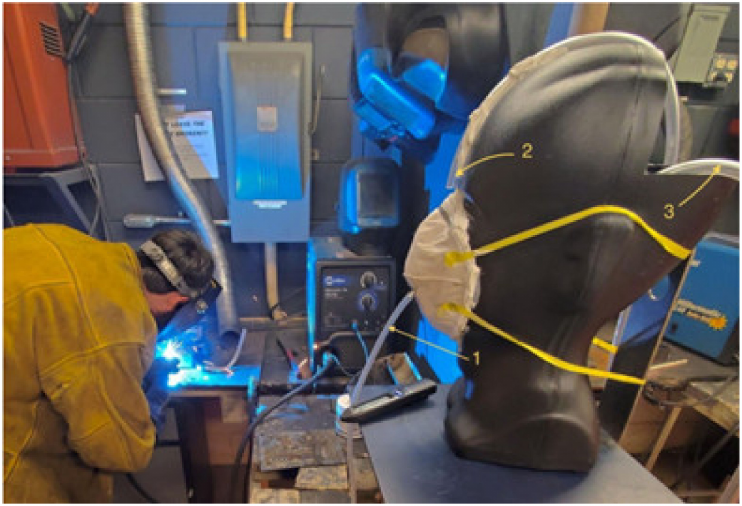
Figure 2. Respirator testing setup with numbered probes.